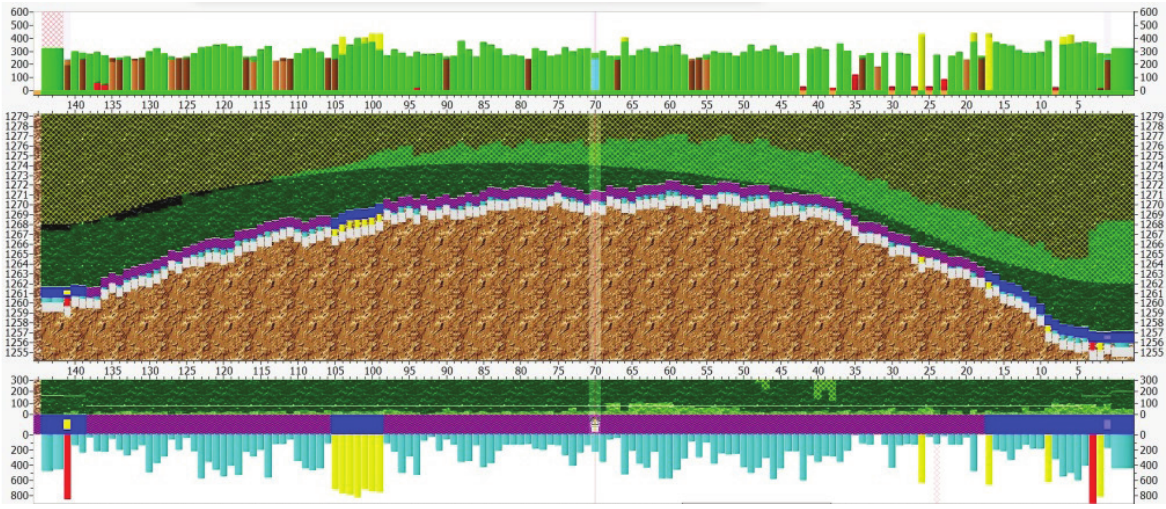
Figure 4: Screenshot from